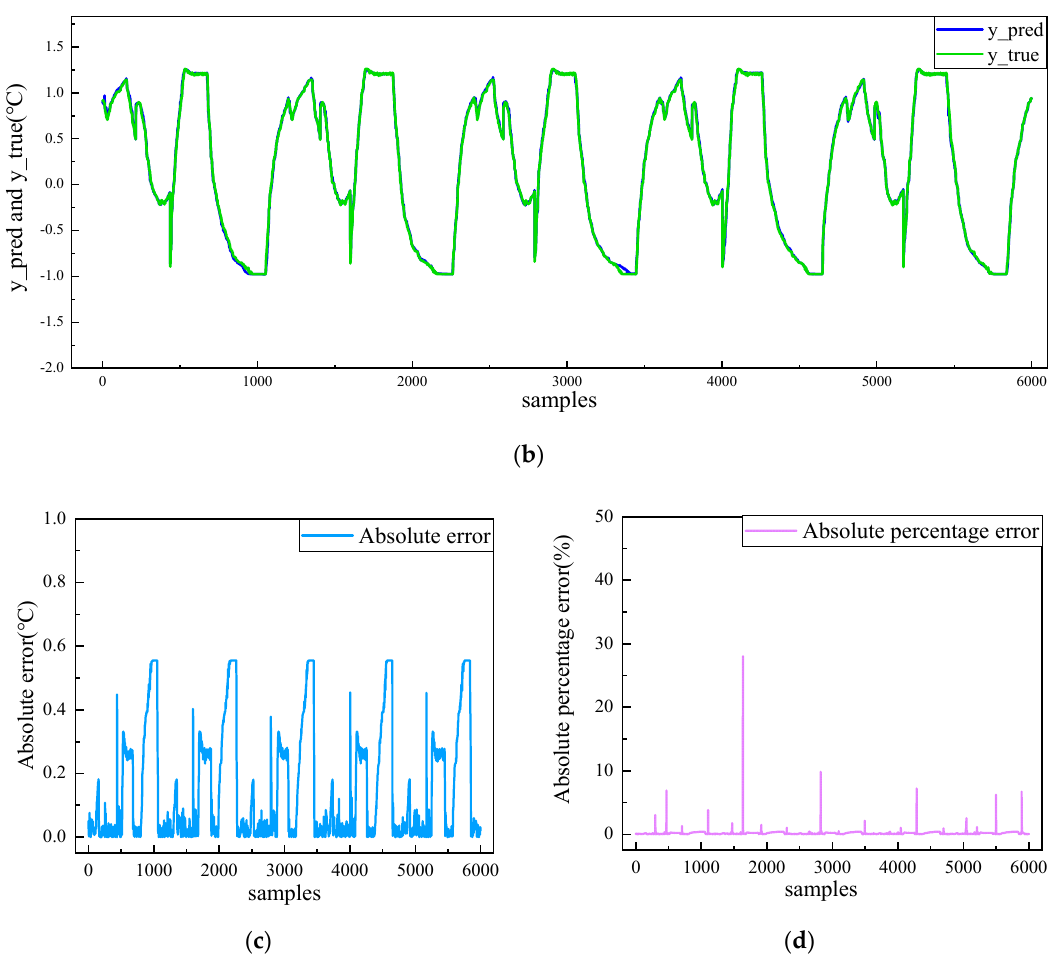
Figure 7. Prediction results. ( a ) Comparison of predicted values and real values. ( b ) Comparison of predicted values and real values after the dataset was normalized. ( c ) Absolute errors of predicted values and real values. ( d ) Absolute percentage errors of predicted values and real values.